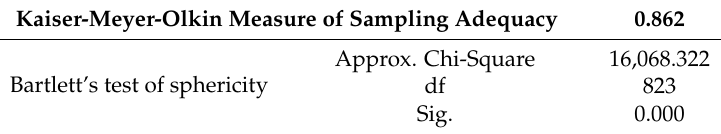
Table 2. KMO and Bartlett’s